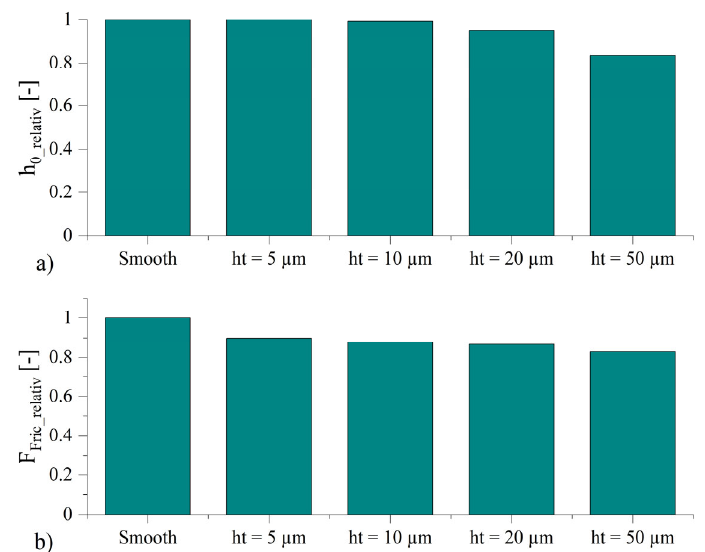
Figure 5 . Results of the hydrodynamic simulation: ( a ) relative lubrication gap clearance, ( b ) relative hydrodynamic friction force.